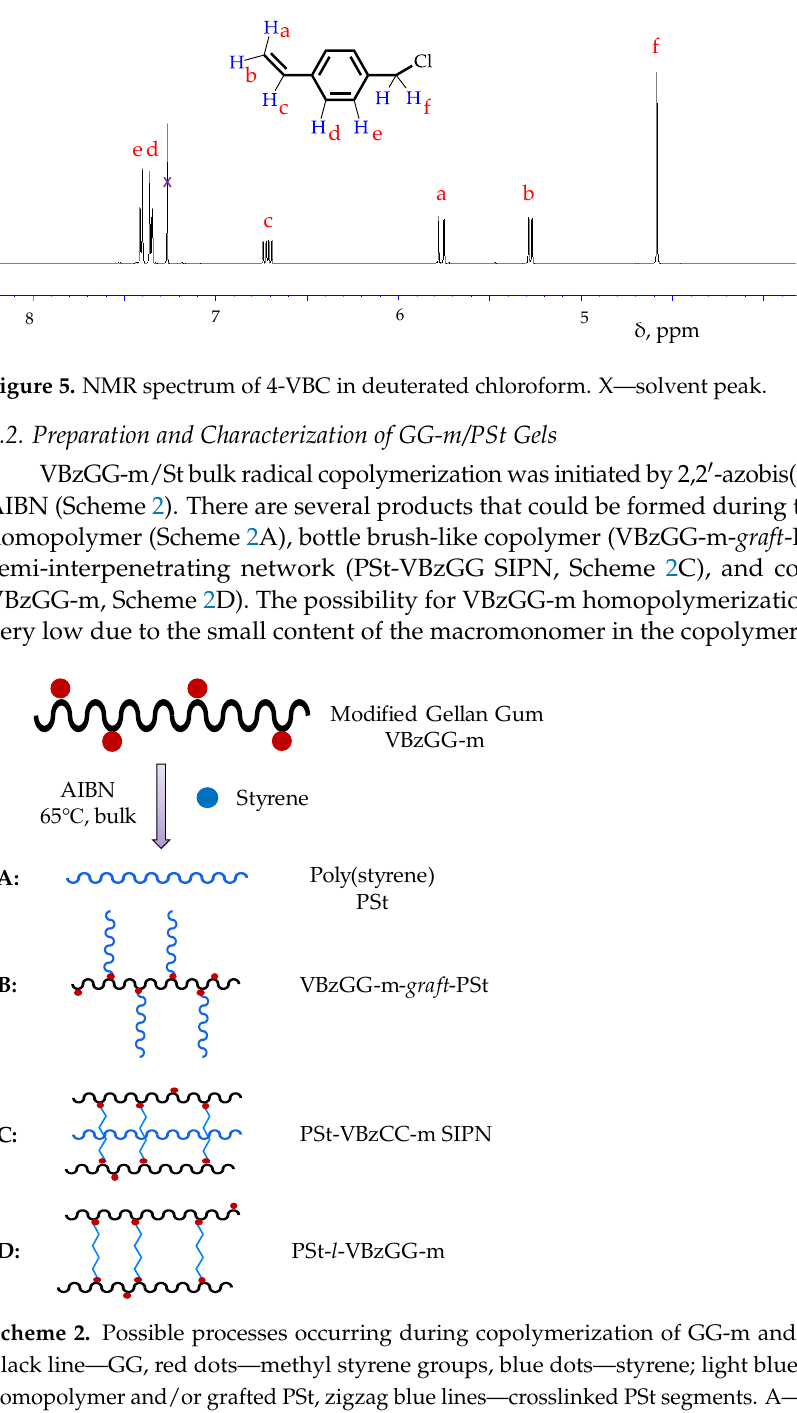
Figure 4. NMR spectra of GG (A) and VBzGG-3 (B) in D 2 O. X — solvent peaks.